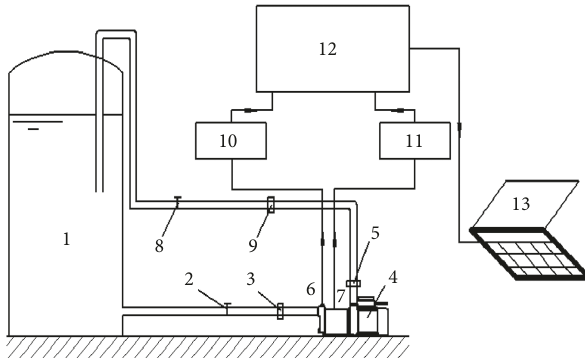
Figure 2: Test system and data acquisition. 1, regulator tank; 2, valve; 3, inlet pressure gauge; 4, pump; 5, outlet pressure gauge; 6, displacement sensor; 7, acceleration sensor; 8, outlet valve; 9, electromagnetic flow meter; 10, acquisition card A; 11, acquisition card B; 12, Bently tester; 13,